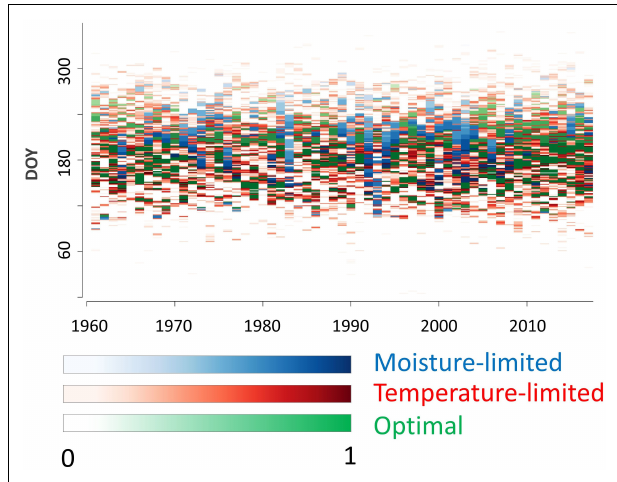
FIGURE 4 | Simulated daily integral growth rates. Color scale indicates the value of integral growth rate and color refers to the dominant climatic limiting